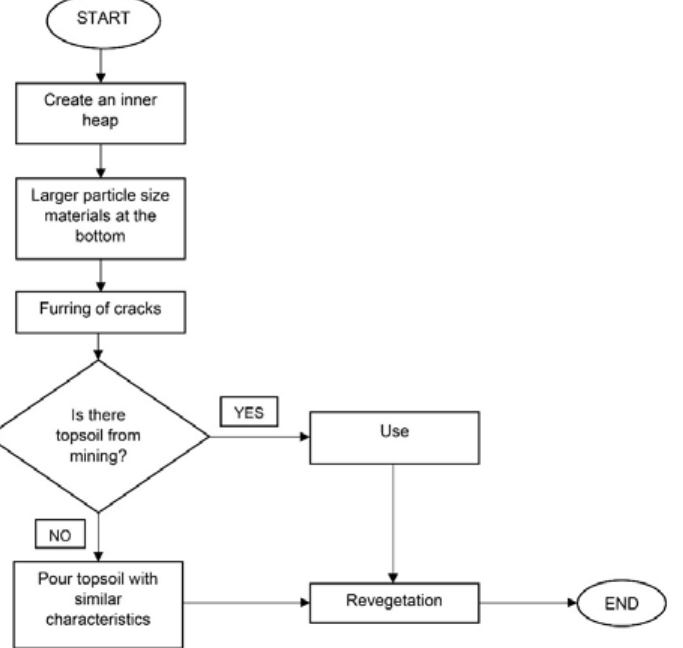
Fig. 6: Flow chart for controlling reject material from mining